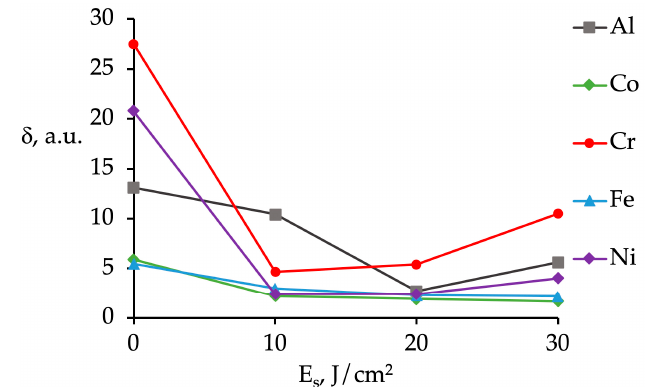
Figure 12. XRD patterns of HEA sample modified with HCPEB with the different energy densities Summarizing the results obtained in the EDS analysis of the initial HEA sample and the material modified by HCPEB characterize an inhomogeneity degree in the distribution of alloying elements in the surface layer presented in Figure 13.